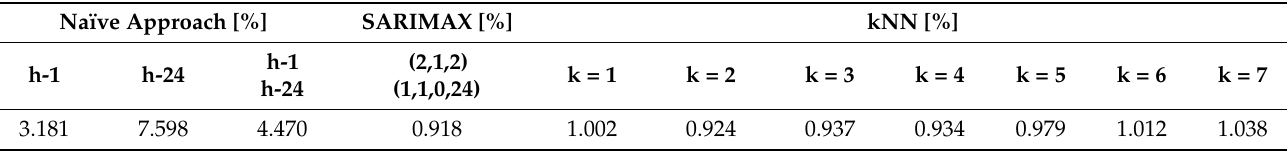
Table 11. MAPE values for naïve approach, SARIMAX model, and kNN algorithm for the sixth verification case. Naïve Approach [%] SARIMAX [%]